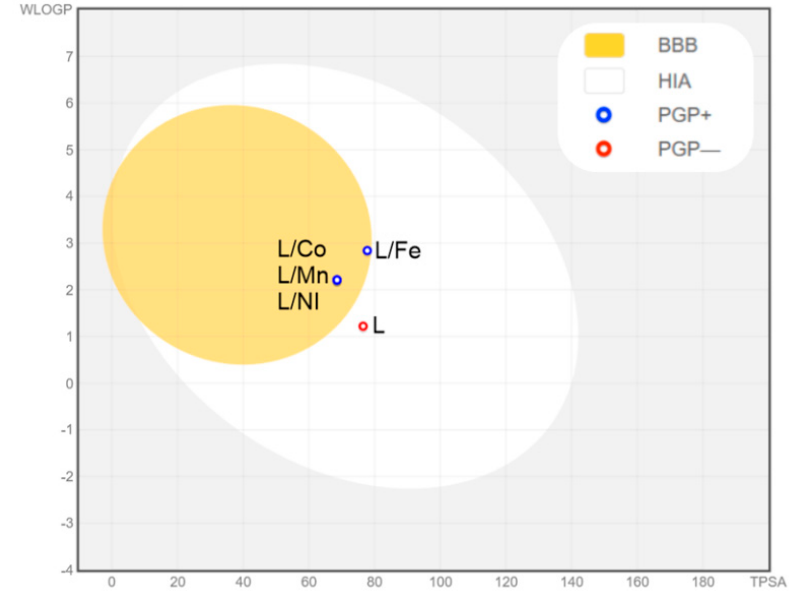
Figure 5. BOILED-Egg diagram for the ligand and obtained metal complexes. BBB (blood–brain barrier); HIA (passive gastrointestinal absorption).